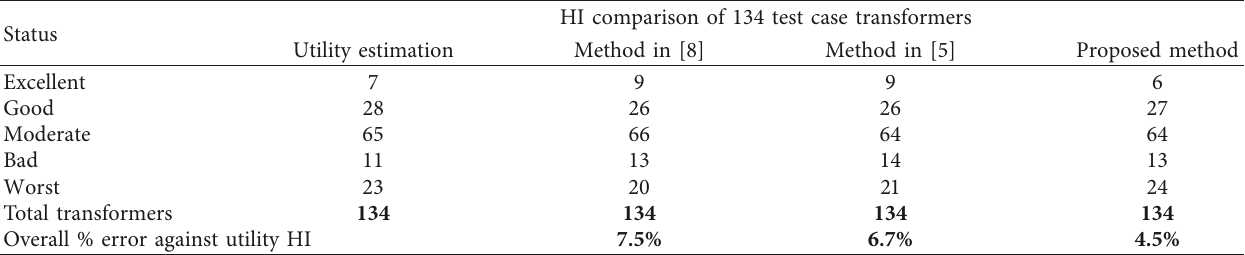
Table 8: HI comparison accuracies for different methods for 134 test